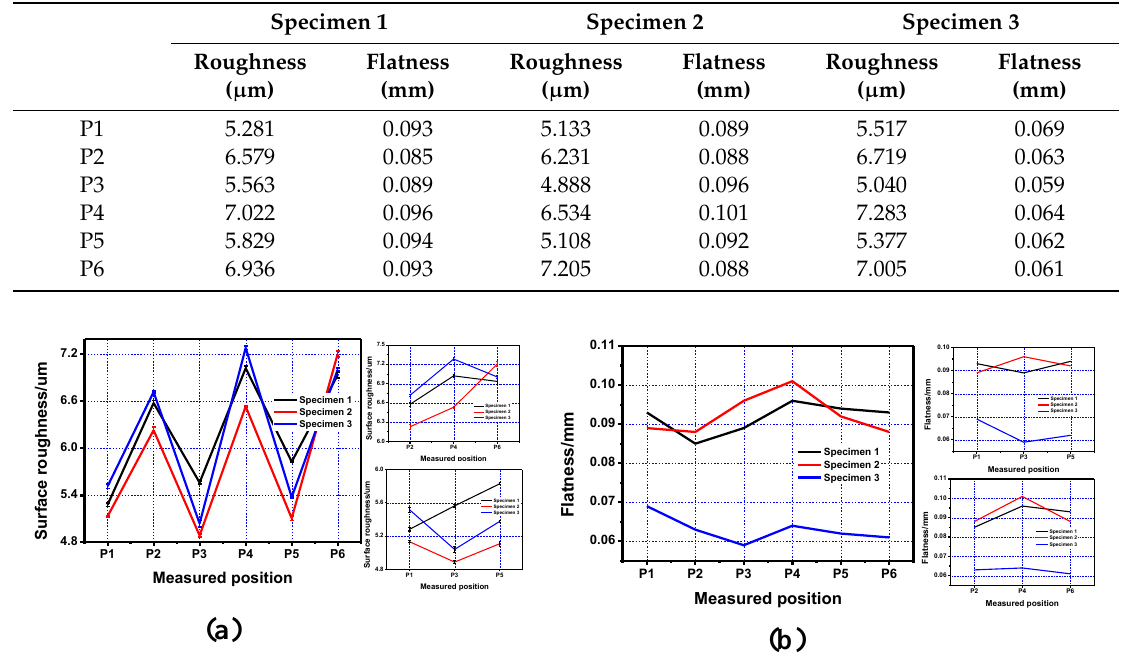
Figure 3. Line charts of roughness and flatness of the positive surface on the inner structure printed using three different scan strategies. ( a ) Positive surface roughness of the printed specimens; ( b ) Positive surface flatness of the printed specimens.